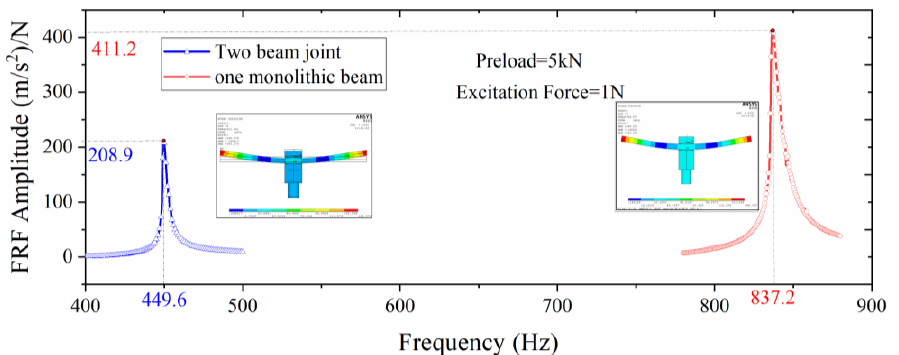
Figure 13. Comparisons of the FRF responses between two beams joint and one monolithic beam.